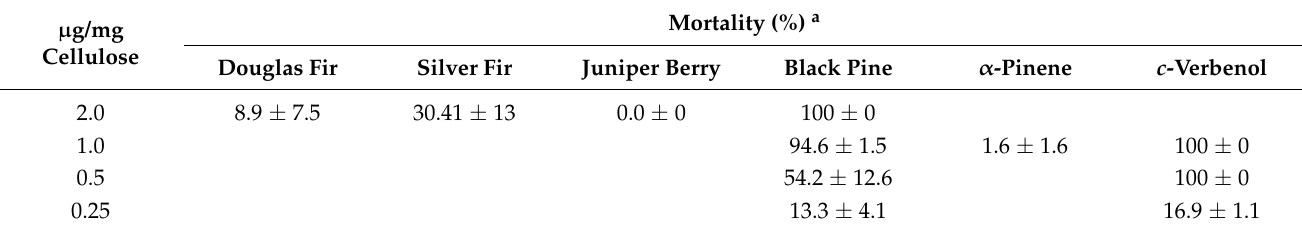
Table 3. Mortality of Hyalomma lusitanicum treated with four essential oils and the major components of black